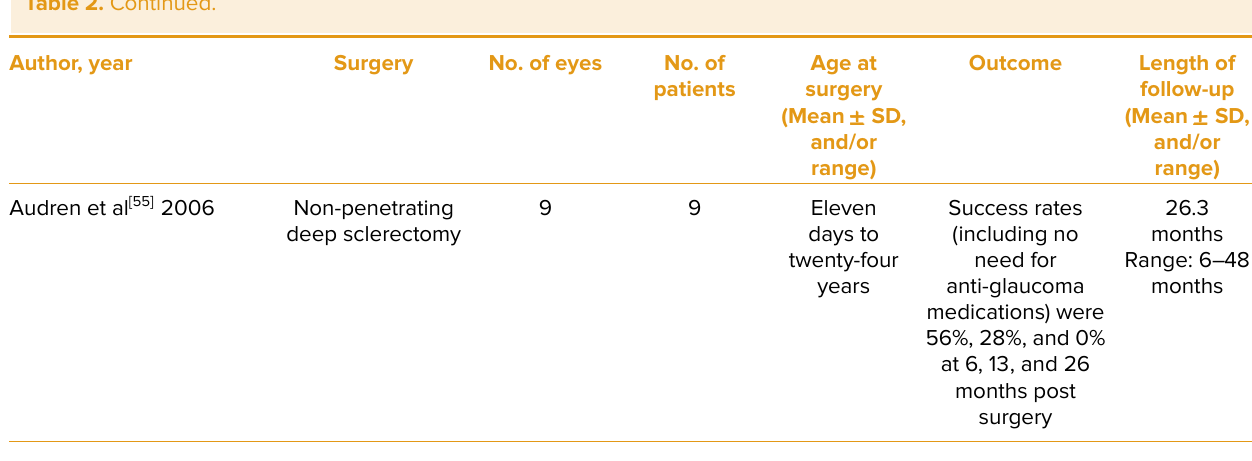
Table 3. Summary of important studies investigating different treatment strategies in diffuse choroidal hemangioma associated with SWS. Only studies with more than three cases were